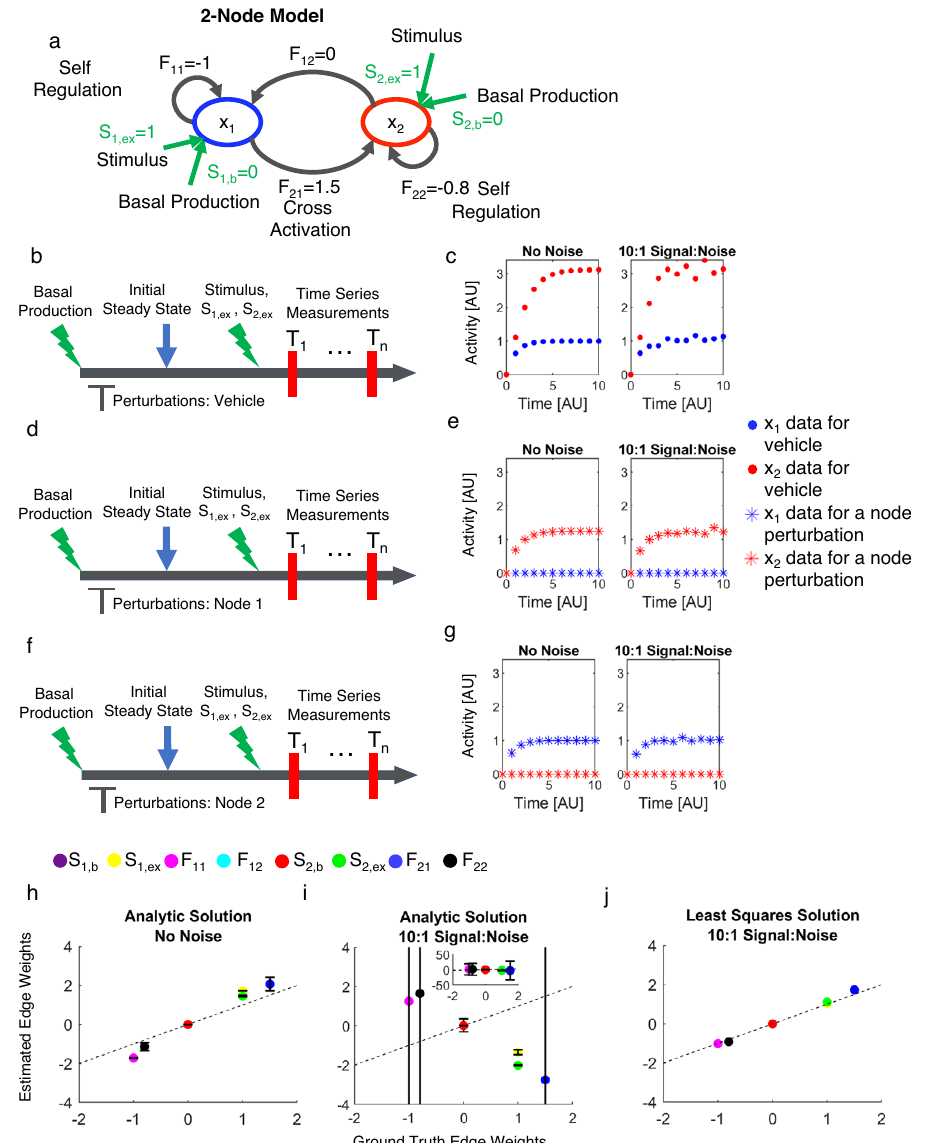
Fig. 1 Overall DL-MRA approach. a Two-node network with Jacobian elements labeled. Green arrows are stimuli and basal production terms. Time course experimental design with perturbations: vehicle ( b ), Node 1 ( d ), Node 2 ( f ). The vehicle may be the solvent like DMSO for inhibition with a drug, or a nontargeting si/shRNA for inhibition with si/shRNA. Simulated time course data for Vehicle perturbation ( c ), Node 1 perturbation ( e ), Node 2 perturbation ( g ) from the network in a . Left Column: no added noise; Right Column 10:1 signal-to-noise added. Actual versus inferred model parameters (S 1,b , S 1,ex , F 11 , F 12 , S 2,b , S 2,ex , F 21 , F 22 ) for direct solution of Eqs. 3 – 4 in the absence ( h ) or presence ( i ) of noise, or with noise and the least-squares approach ( j ). In h and i , error bars are standard deviation across time